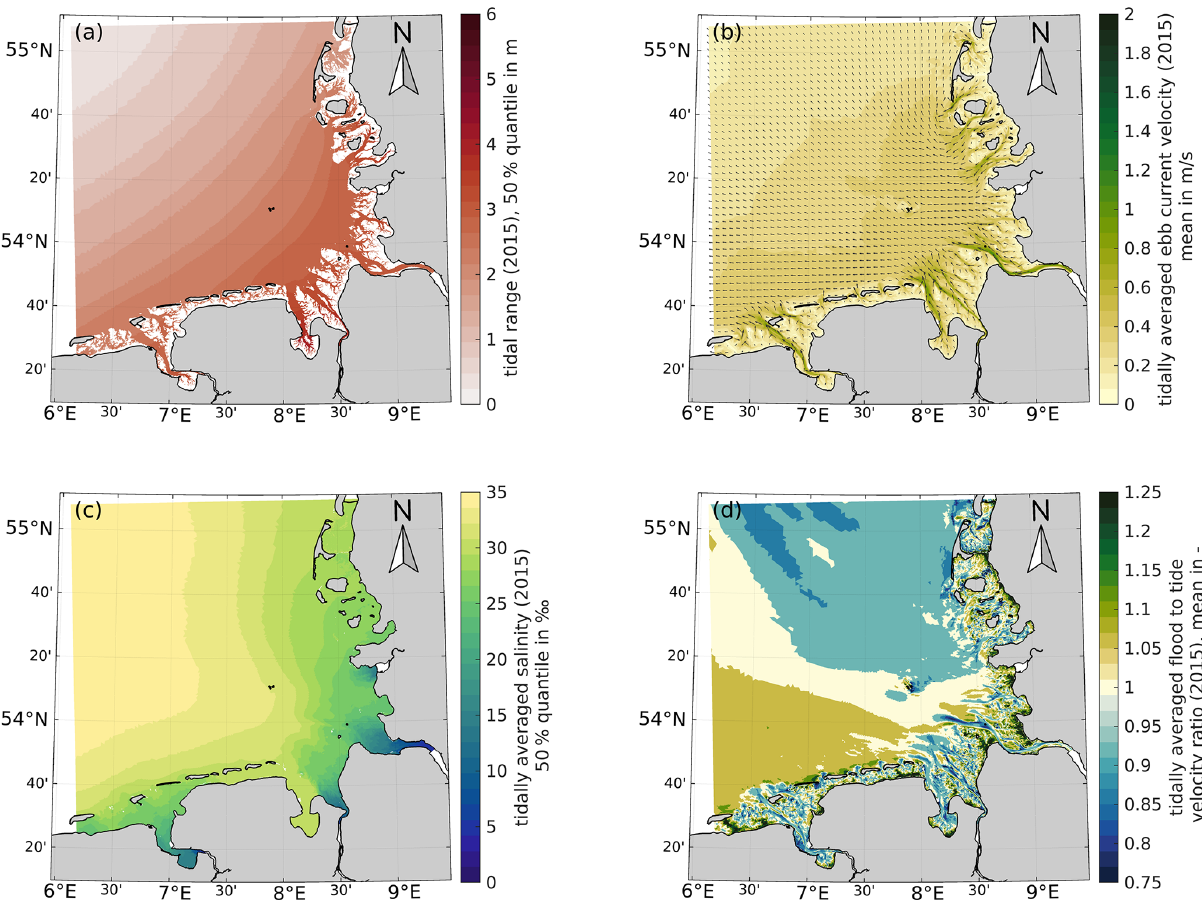
Figure 8. Examples of tidal characteristic values for 2015: 50% quantile of tidal range (a) , mean tidally averaged and depth-averaged ebb current velocity (b) , mean depth-averaged salinity (c) , and ratio of mean flood and mean depth-averaged tidal current velocity (d) .